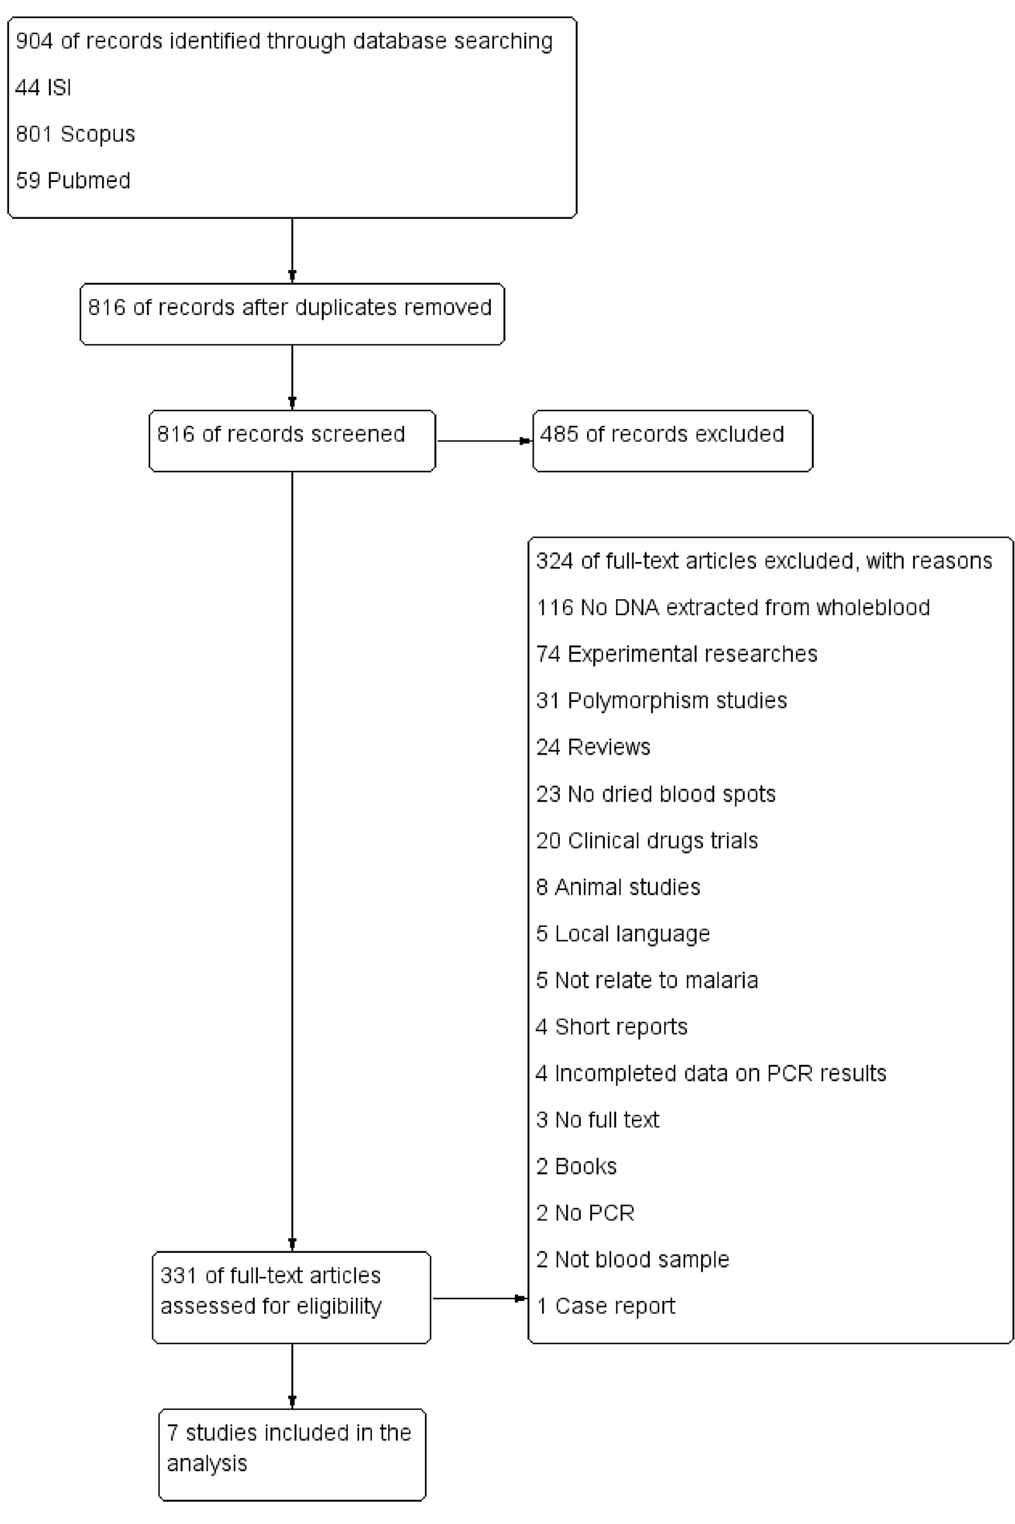
Figure 1. Flow chart for study